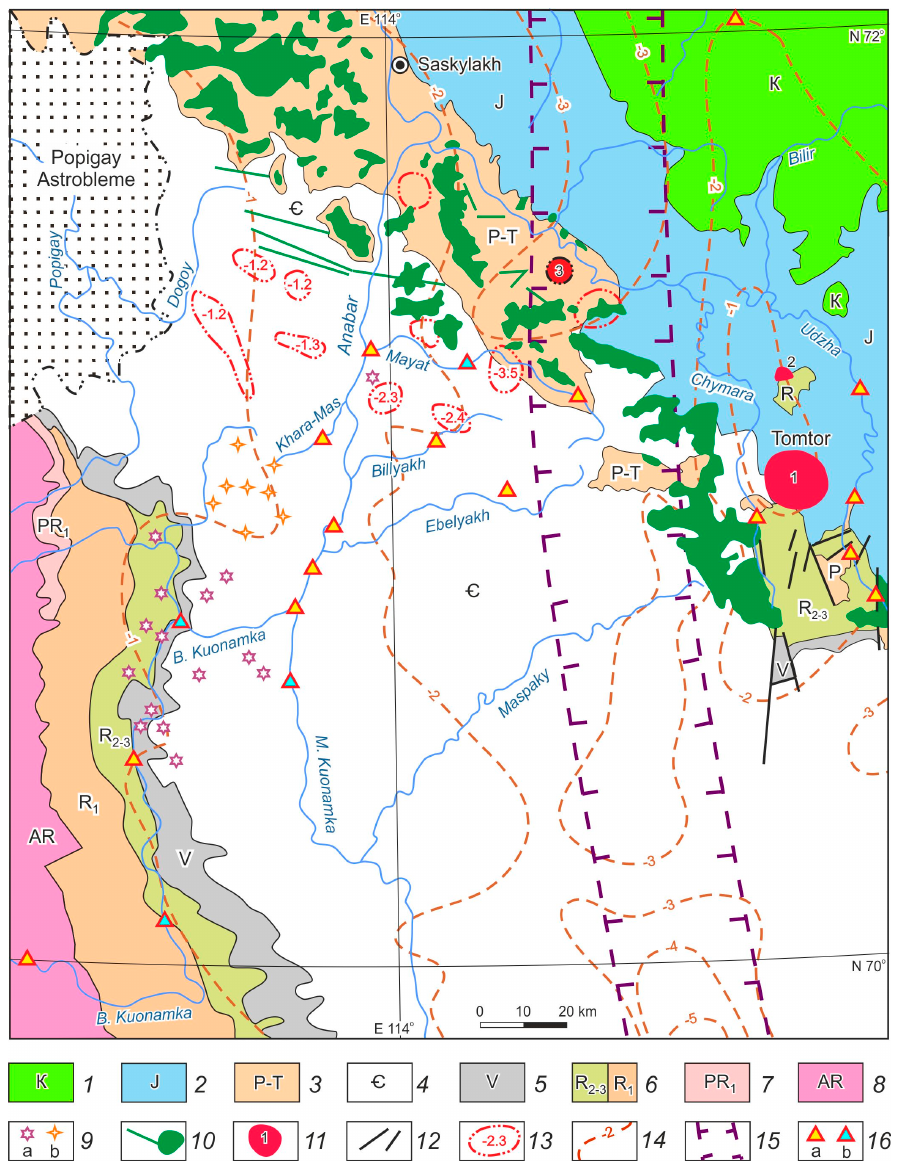
Figure 6. Schematic geological map of the distribution of gold–platinum-bearing placers in the basin of the middle course of the Anabar river (modified after [19]): 1 — Cretaceous sands, silts and gravels; 2 — Jurassic conglomerates, sandstones, siltstones; 3 — Permian and Triassic sandstones, siltstones; 4 — Cambrian dolomites, limestones and sandstones; 5 — Vendian sandstones, siltstones and conglomerates; 6 — middle-upper Riphean (R 2-3 ) and lower Riphean (R 1 ) conglomerates, sand- stones, siltstones, argillite and dolomites; 7 — Lower Proterozoic rocks; 8 — Archean metamorphic complexes; 9—kimberlite (a) and carbonatite (b) pipes of the Orto–Yargin field; 10—dykes and sills of P–T basites; 11—complexes of alkaline-ultrabasic rocks with carbonatites (1—Tomtor, 2—Bogdo, 3—Chyuempe); 12—faults; 13—anomalies of the potential intrusive massifs of basic, alka- line-ultrabasic rocks in the basement and lower layer of the platform cover (based on geophysical data), figure-estimated depths (-n km) of occurrence; 14—isolines of basement surface (-n km); 15—borders of the Udzhinsky aulacogen; 16—sampling sites of the placer samples of platinum and gold (a) and PGM in association with palladium gold (b). Scheme is based on Geological and Tec- tonic maps of Yakutia at a scale of 1:1,500,000.